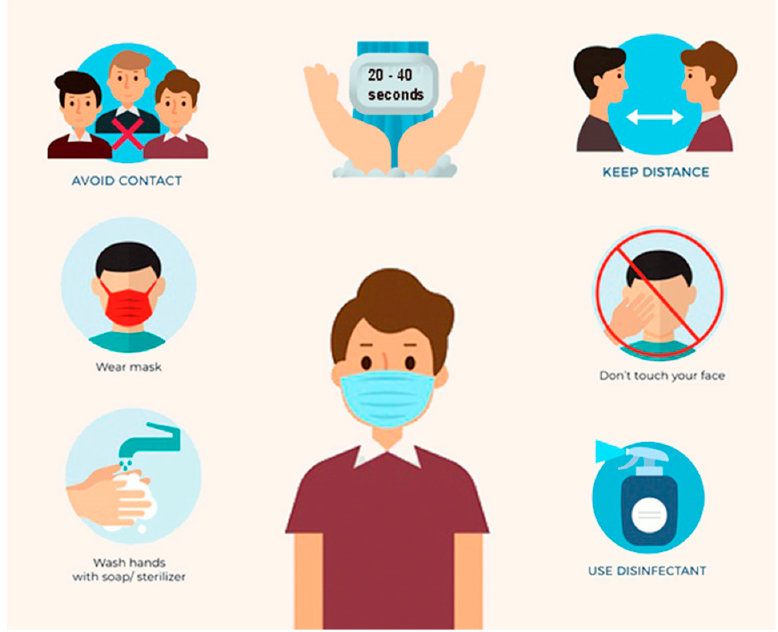
Figure 9. How to protect yourself from the COVID-19 (figure drawn by Giovanna Dipalma) .